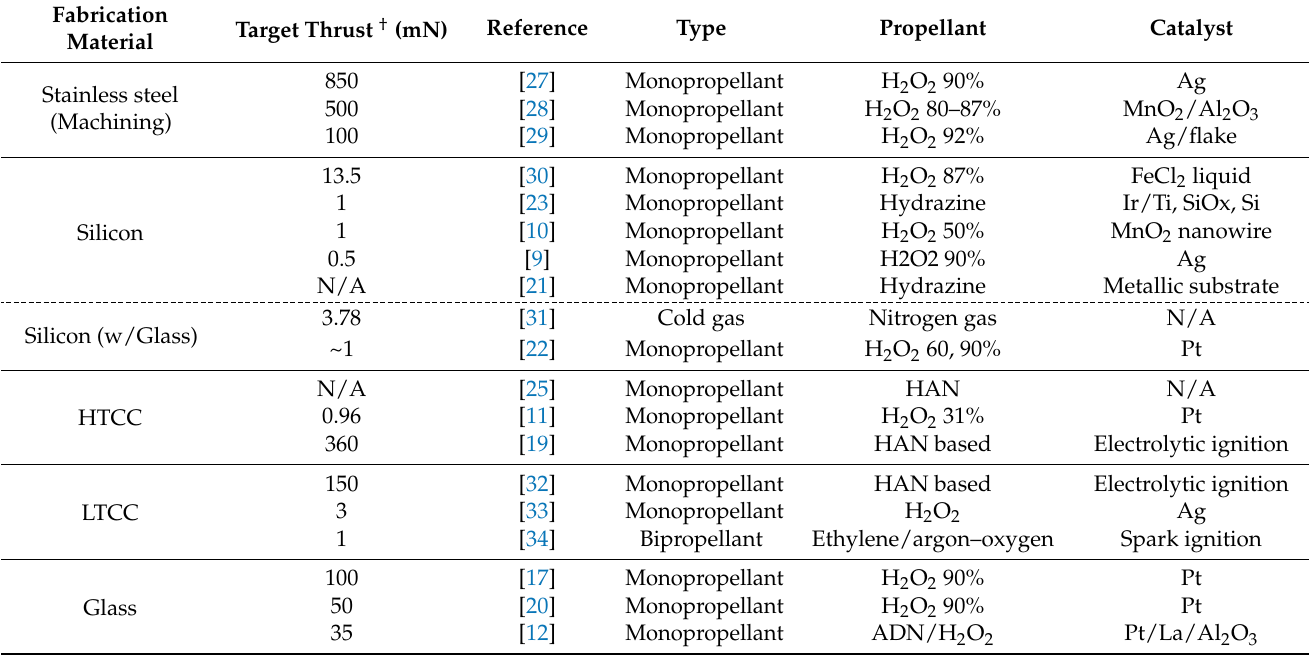
Table 1. Summary of the fabrication materials used in previous micro-propulsion